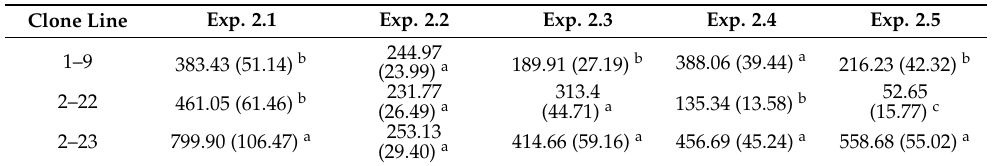
Table 5. The average number of maturated embryos by clone line with standard error in brackets obtained from Picea pungens maturation